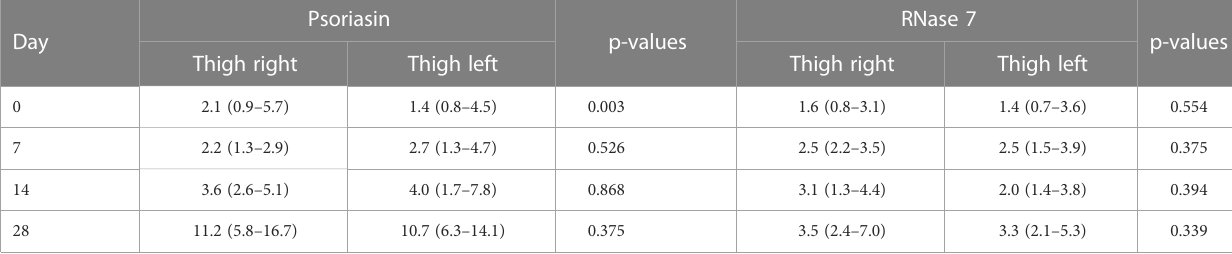
RNase 7 p-values p-values